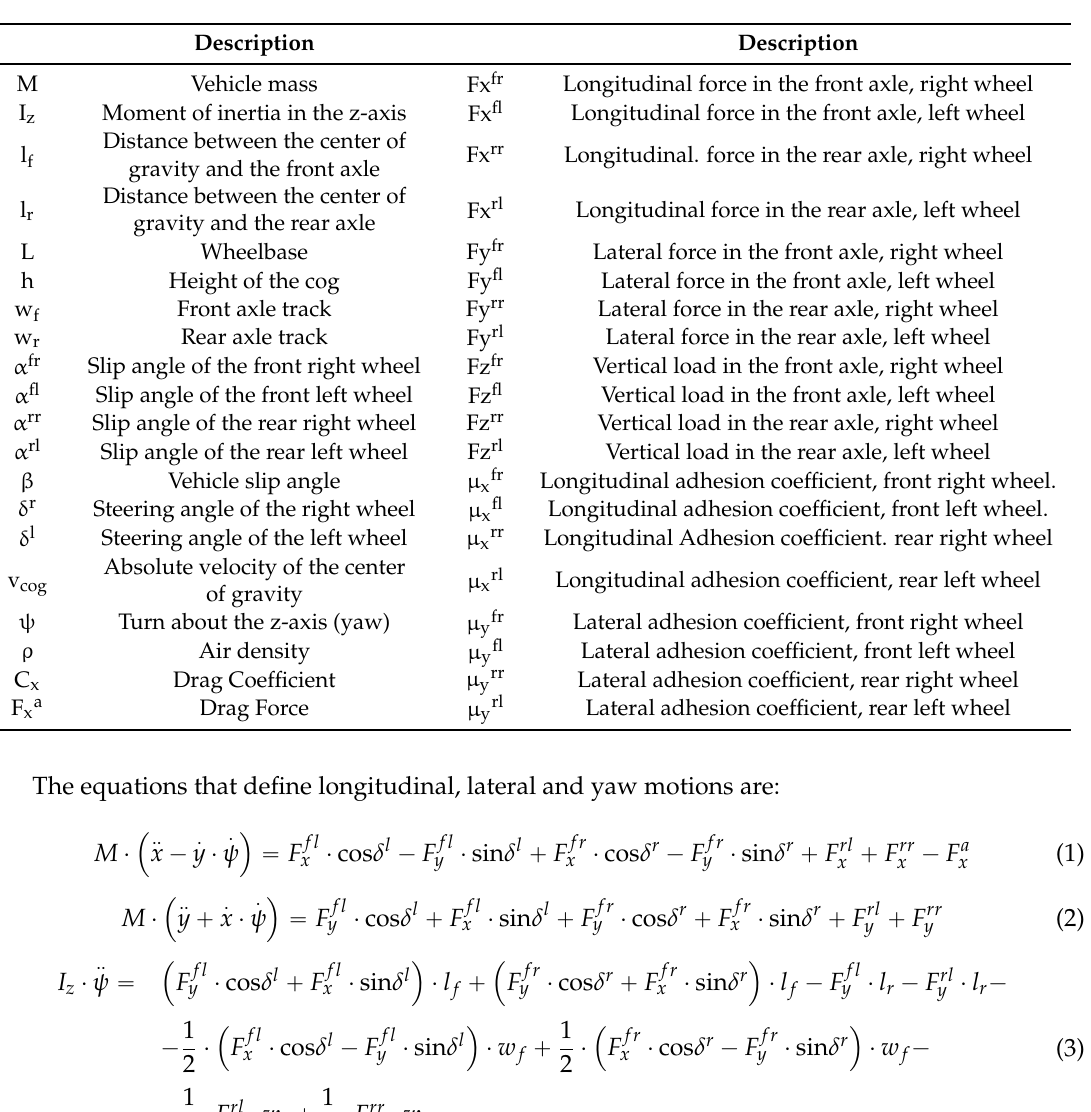
Table 2. Parameters in the four-wheel longitudinal-lateral